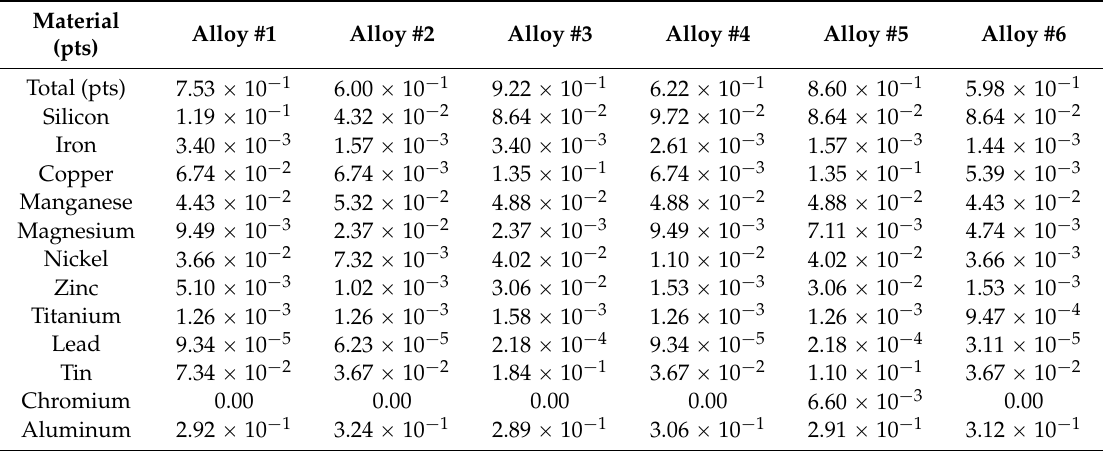
Table 9. Minimum environmental impact of 1 kg of the studied aluminum